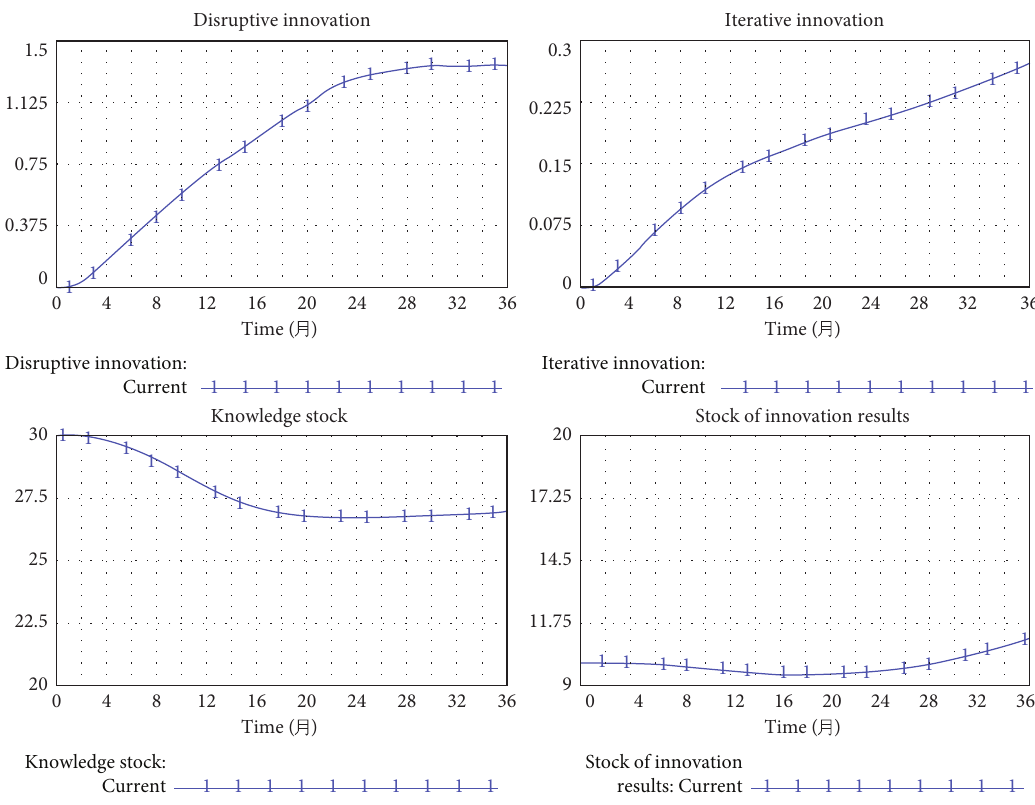
Figure 4: Simulation results of system